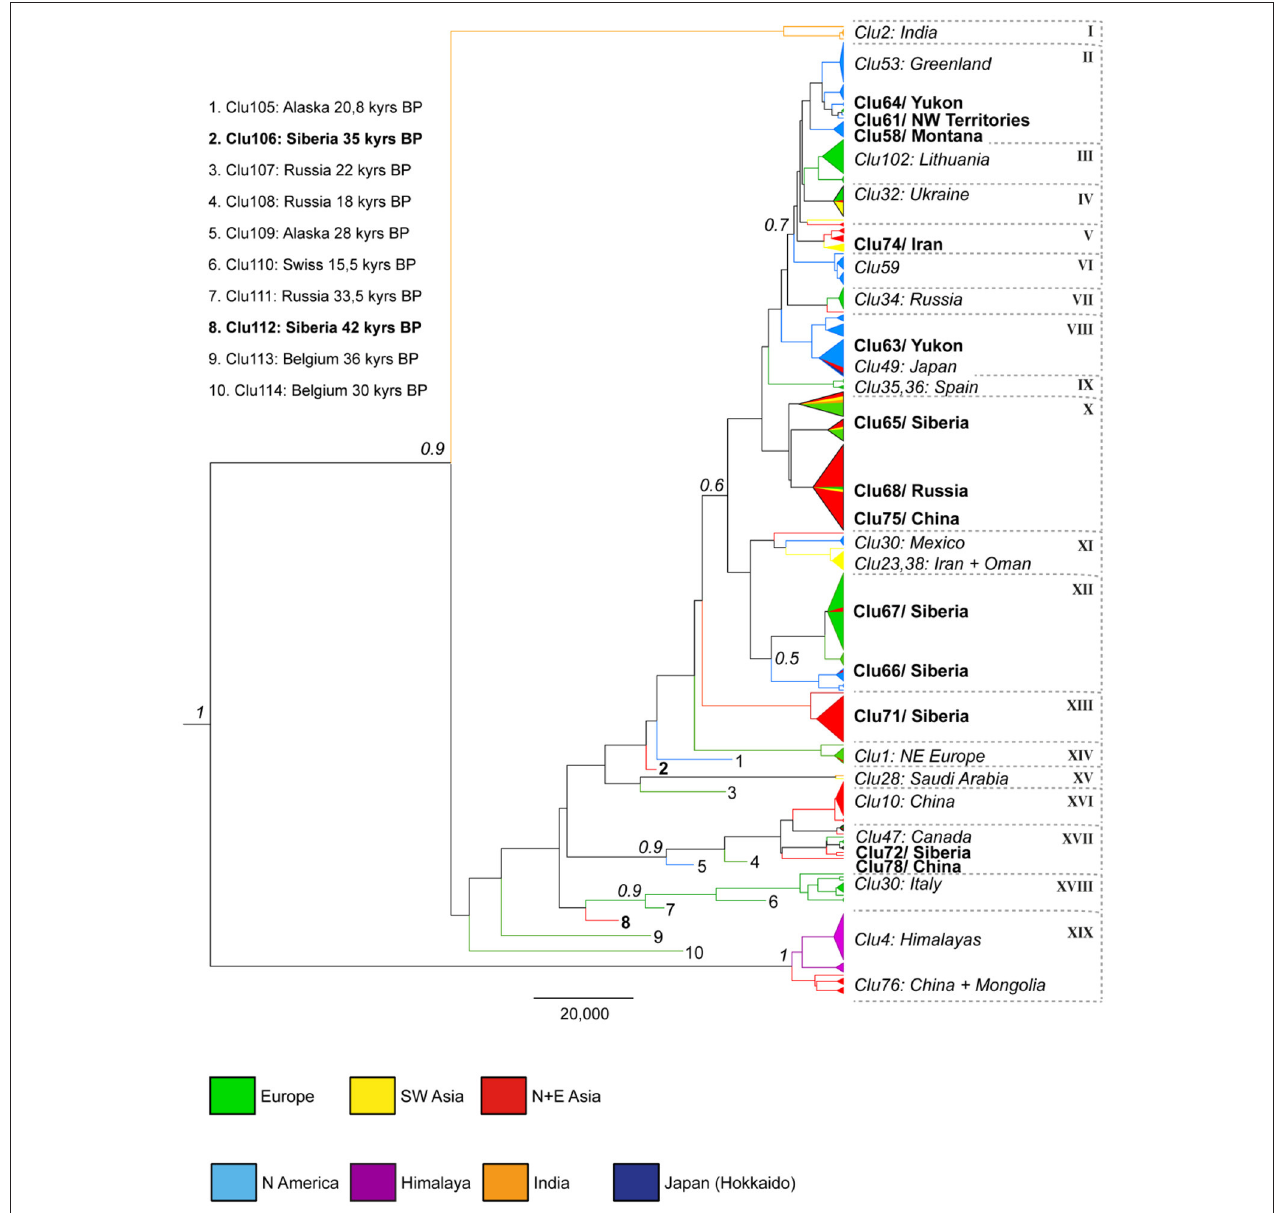
FIGURE 1 | Maximum clade credibility tree based on alignment A from the Bayesian analysis (BEAST) using the posterior distribution from 30 million sampled trees. Nodes with posteriors above 50% are indicated. Key regions/haplotypes are indicated and Late Pleistocene samples are represented with numbers 1–10 and listed in the figure. Novel haplotypes are displayed in bold and clades are denoted